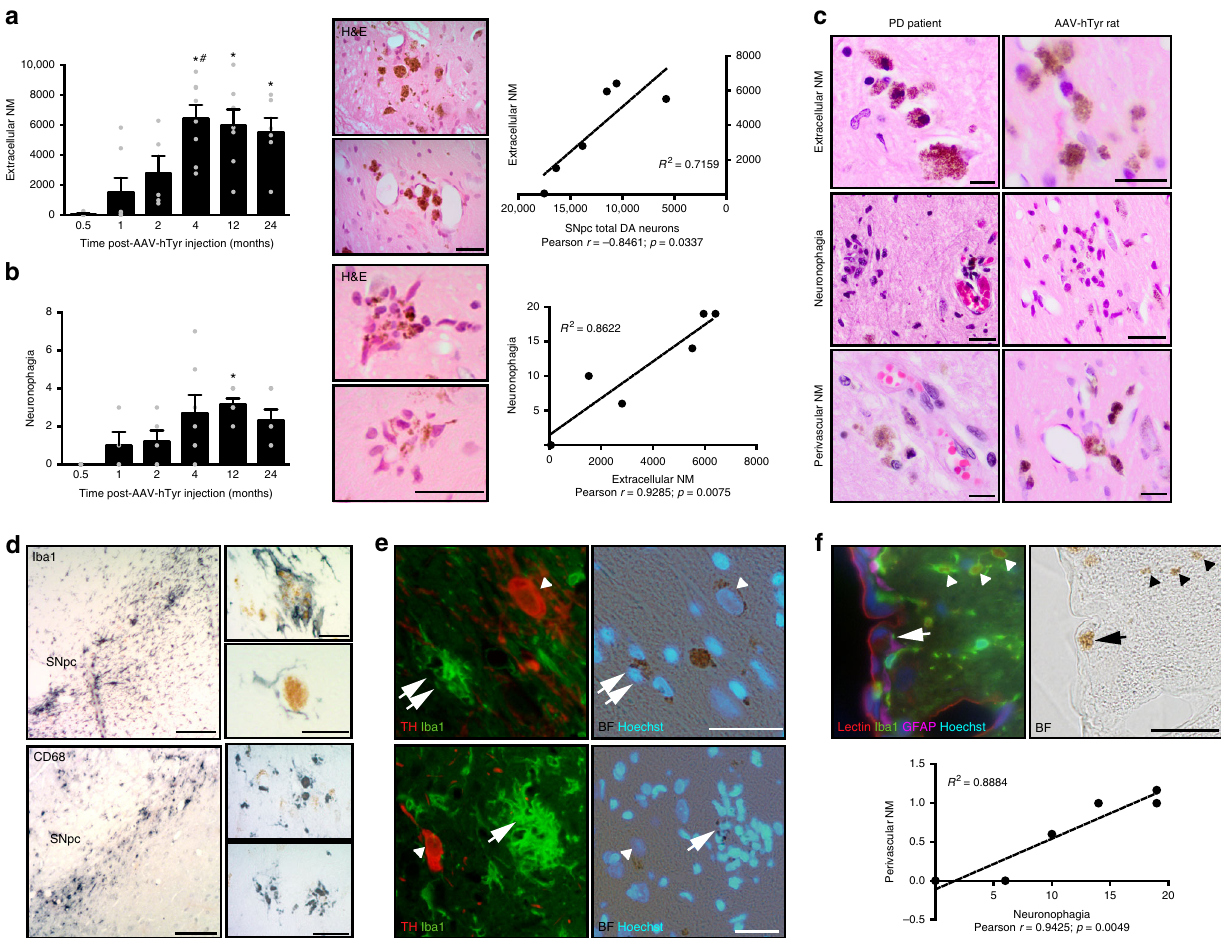
Fig. 5 Extracellular NM and neuronophagia in AAV-hTyr-injected rats. a Left, extracellular NM aggregates in ipsilateral SNpc from AAV-hTyr-injected rats. * p < 0.05, compared to 0.5&1 m; # p < 0.05, compared to 2 m (one-way ANOVA; Student – Newman – Keuls post-hoc test). Middle, hematoxylin-eosin